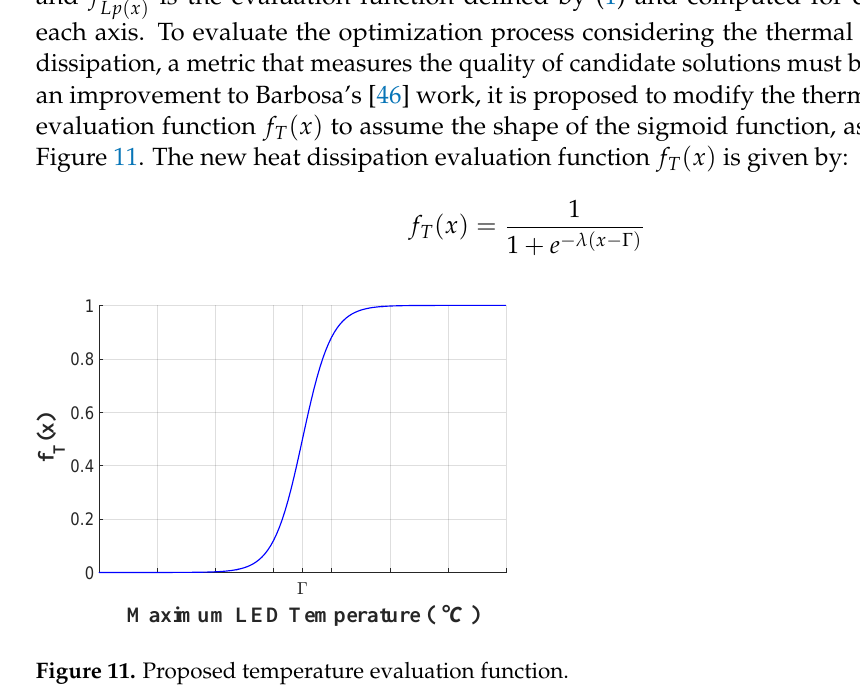
Figure 11. Proposed temperature evaluation